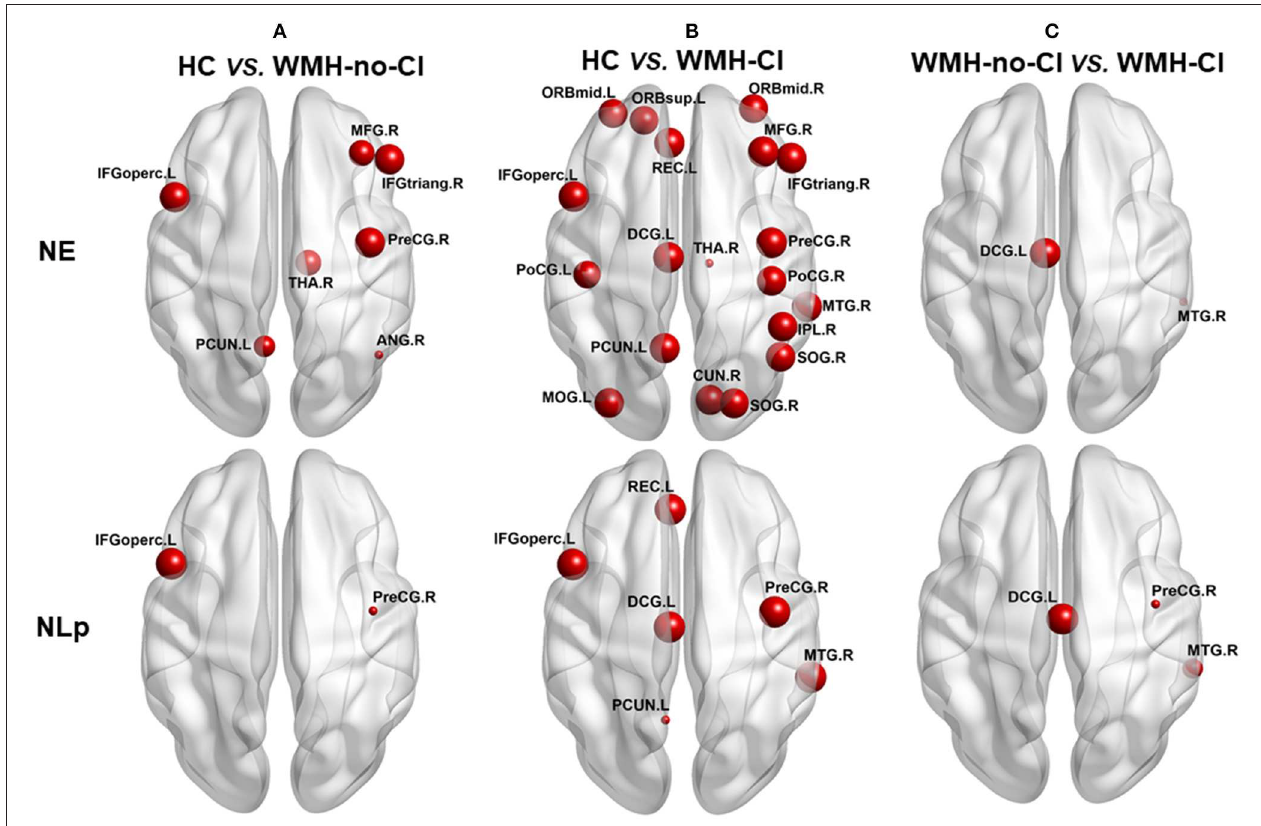
FIGURE 2 | Post hoc analyses of group differences in nodal efficiency and nodal path length. The impaired regions were marked with red nodes. Node size represented the between-group differences ( P < 0.05, Bonferroni-corrected). (A) post hoc analyses of group deferences in nodal efficiency and nodal path length between HC and WNH-no-CI. (B) post hoc analyses of group deferences in nodal efficiency and nodal path length between HC and WNH-CI. (C) post hoc analyses of group deferences in nodal efficiency and nodal path length between WNH-no-CI and WMH-CI. ANG, angular gyrus; CI, cognitive impairment; CUN, cuneus gyrus; DCG, median cingulate and paracingulate gyrus; HC, health control; IFGoperc, opercular part of inferior frontal gyrus; IFGtriang, triangular part of inferior frontal gyrus; IPL, inferior parietal; L, left; MFG, middle frontal gyrus; MOG, middle occipital gyrus; MTG, middle temporal gyrus; NE, nodal efficiency; NLp, nodal path length; ORBmid, orbital part of middle frontal gyrus; ORBsup, orbital part of superior frontal gyrus; PCUN, precuneus; PoCG, postcentral gyrus; PreCG, precentral gyrus; REC, rectus gyrus; R, right; SOG, superior occipital gyrus; THA, thalamus; WMH, white matter hyperintensity.